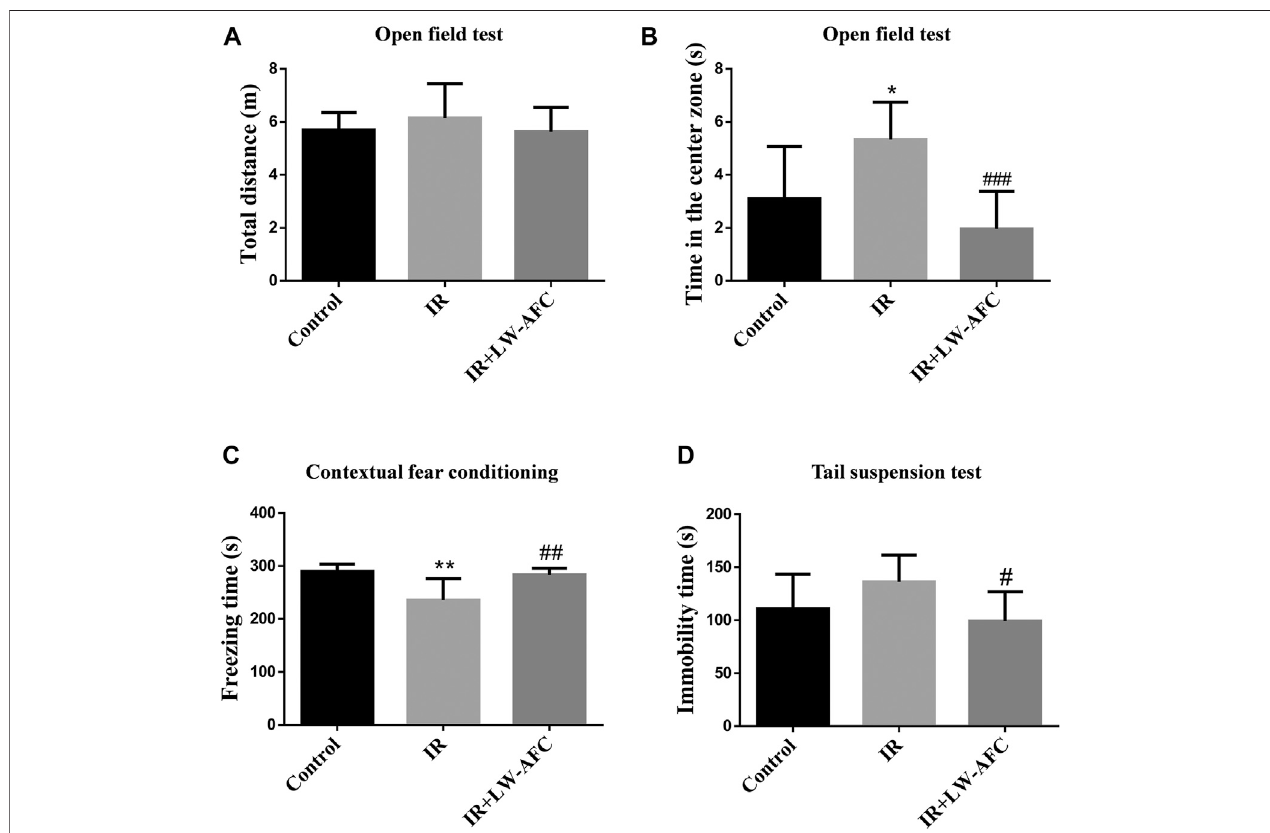
FIGURE 3 | LW-AFC improves cognitive and emotional dysfunctions in IR mice on day 1 after irradiation. (A) Quanti fi cation of the total distances travelled by mice during the open fi eld test. (B) Quanti fi cation of the center time of mice during the open fi eld test. (C) Quanti fi cation of the freezing time of mice during the contextual fear conditioning test. (D) Quanti fi cation oftheimmobility time ofmice during thetail suspension test. The values denote mean ± S.D., n (cid:2) 8. * p < 0.05 and ** p < 0.01, versus the control group; # p < 0.05, ## p < 0.01, and ### p < 0.001, versus the IR group. Abbreviation: IR,